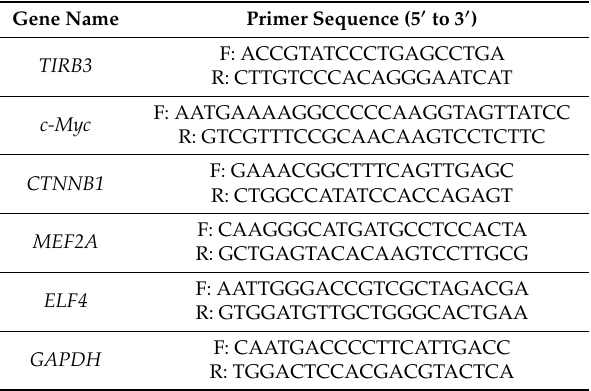
Table 1. Primers sequences used in this